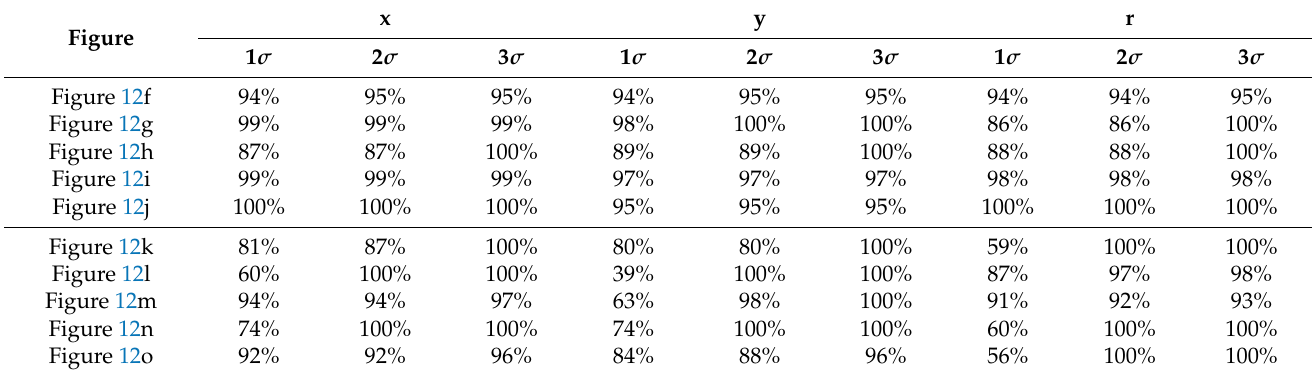
Table 6. Hit percentage for each detected parameter based on 1, 2, and 3 σ criterion.